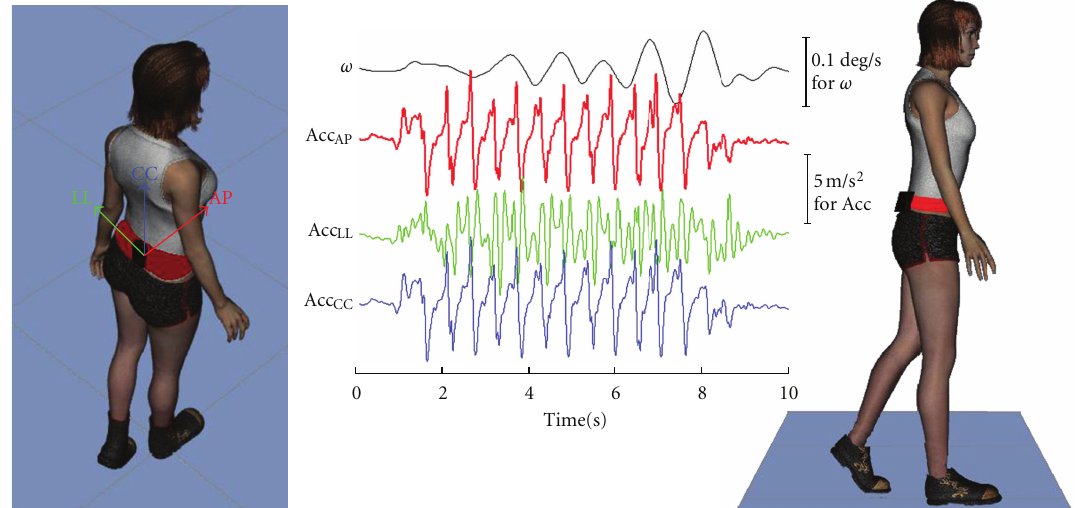
Figure 1: Schematic representation of gait stability assessment. A schematic representation of the walking test performed by a subject and the collected raw signals. Each subject performed the test wearing the red belt including the black device located on the back. Raw signals of cranio-caudal angular velocity ( (cid:2) , black) and of acceleration signals along antero-posterior (Acc AP , red), latero-lateral (Acc LL , green), and cranio-caudal (Acc CC , blue) axes are